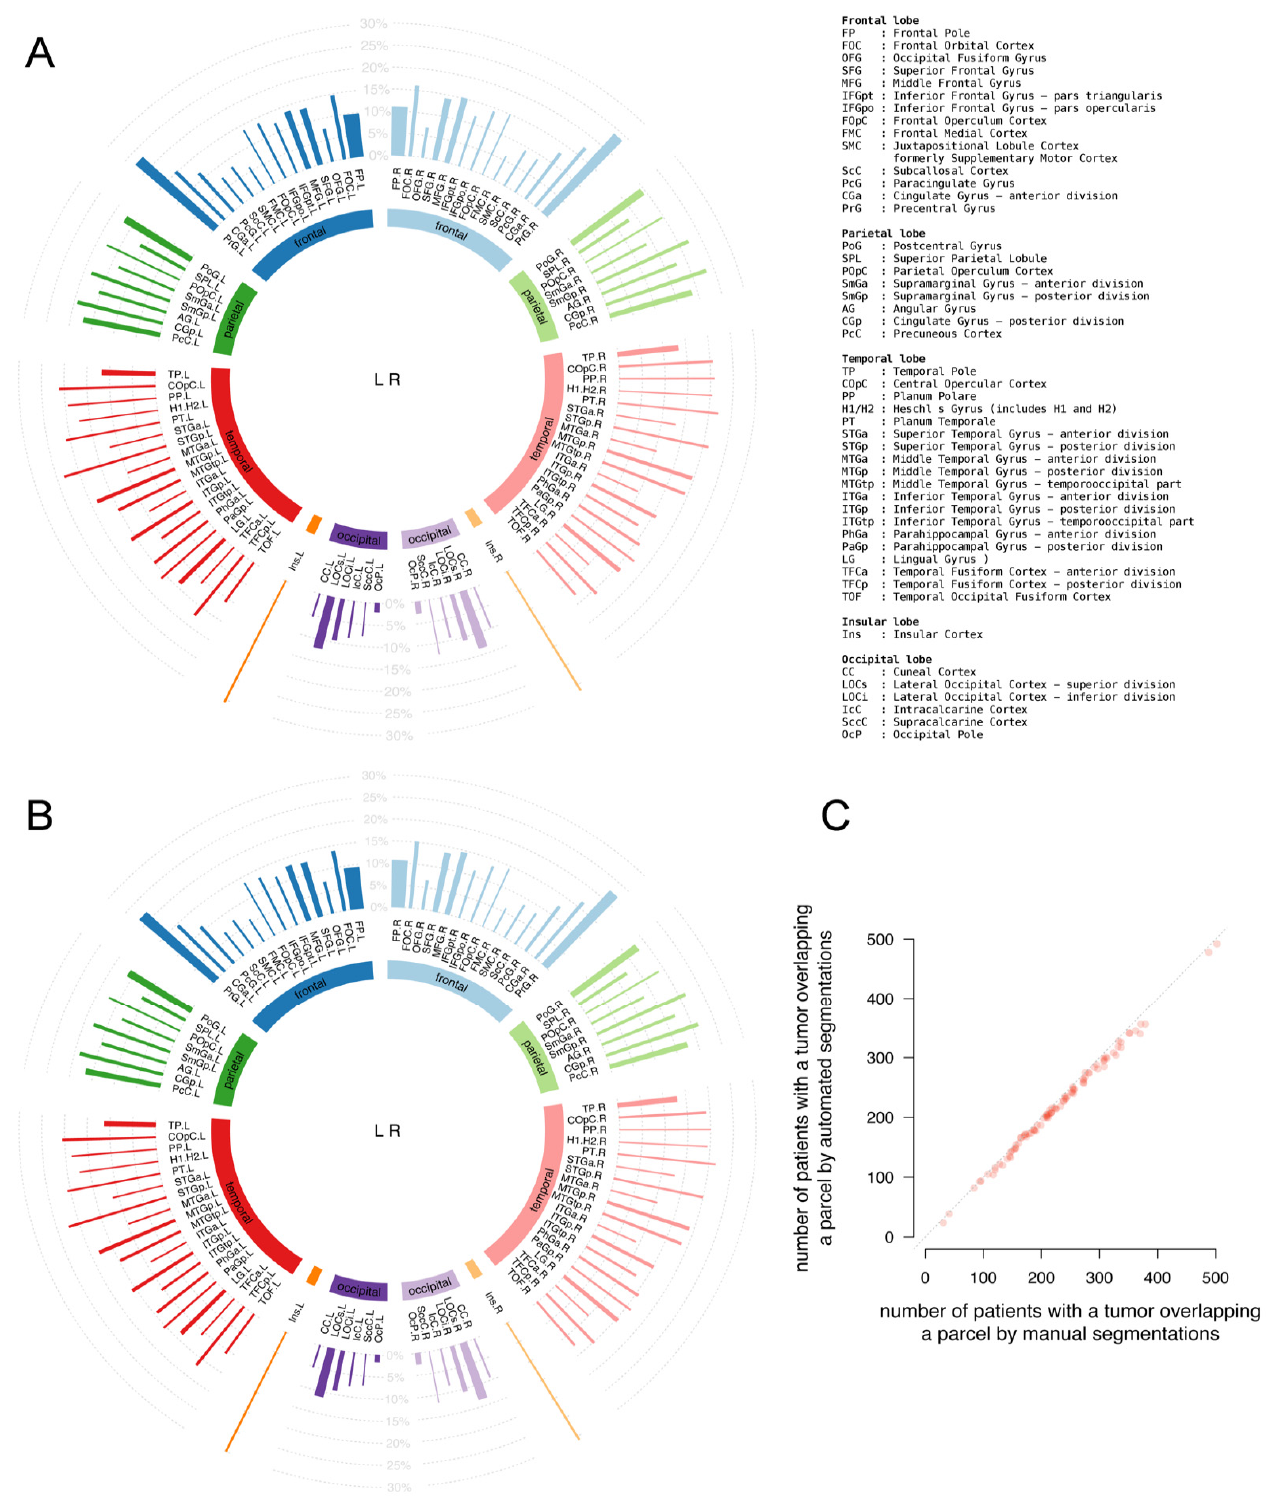
Figure 3. Comparison of tumor location profiles of cortical structures between ( A ) automated and ( B ) manual segmentations in Desikan’s brain parcellation. In the circular bar plots, each bar represents one parcel from the Desikan’s brain parcellation categorized by lobe. Abbreviations are referring to anatomical parcels as detailed in the legend. The height of a bar represents the percentage of patients, indicated in grey, with tumor involvement in a parcel. The width of a bar corresponds with the relative volume of a parcel. ( C ) Correlation plot between the number of patients with parcel involvement between the manual and automated segmentations. The dotted diagonal indicates the identity line.